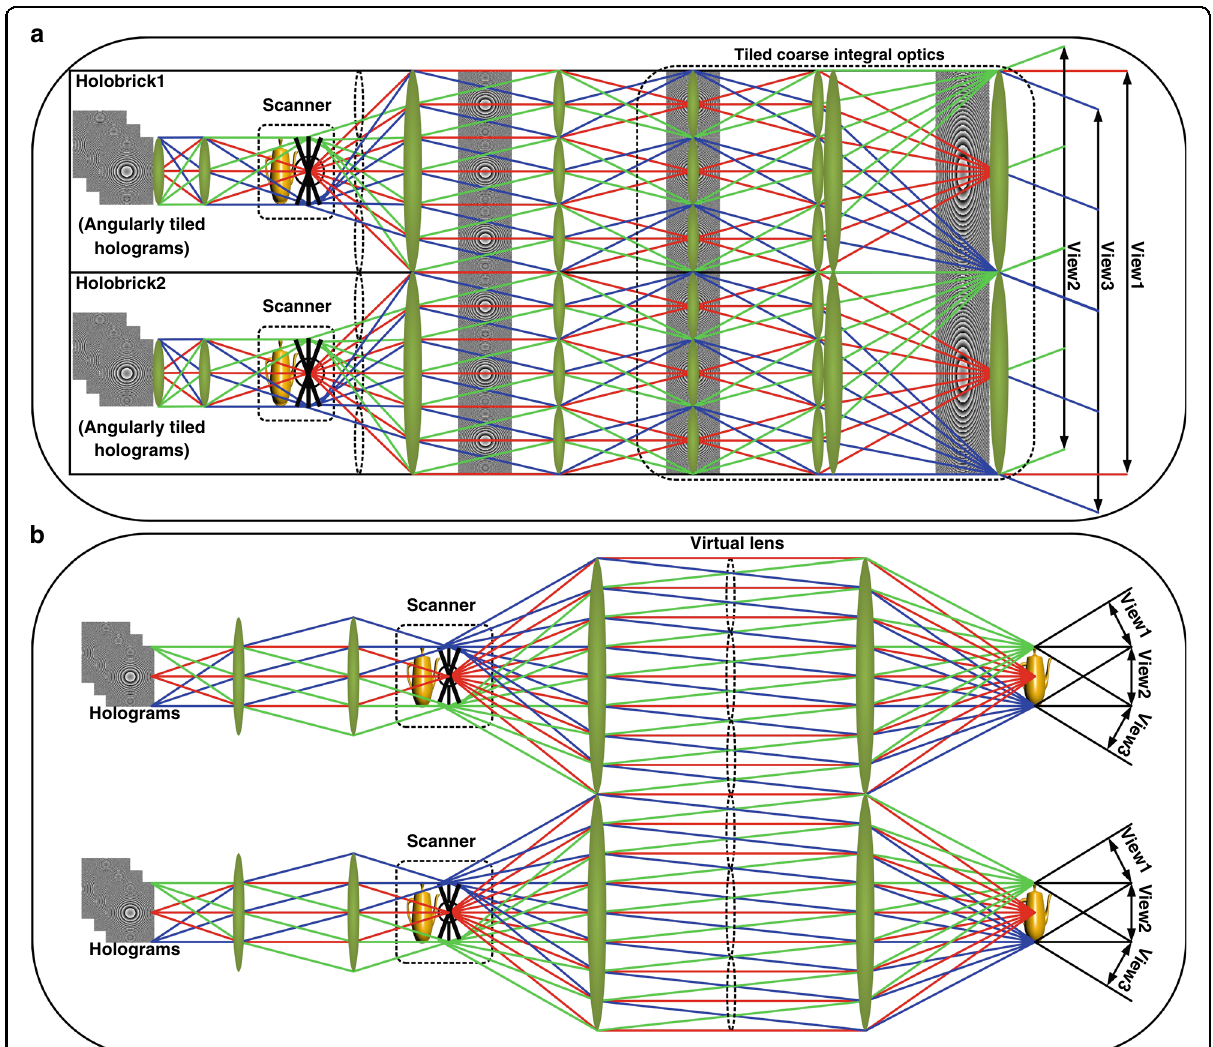
Fig. 3 Schematic of scanning CIH using modular coarse integral optics for spatial tiling of scanned holobricks. a Two scanned modular CIHs in two scanned holobricks spatially tiled to achieve the same FOV angle but the doubled size of the reconstructed holographic image, b the previous scanning sub-system in the complete bandwidth-utilization CIH con fi guration that is not